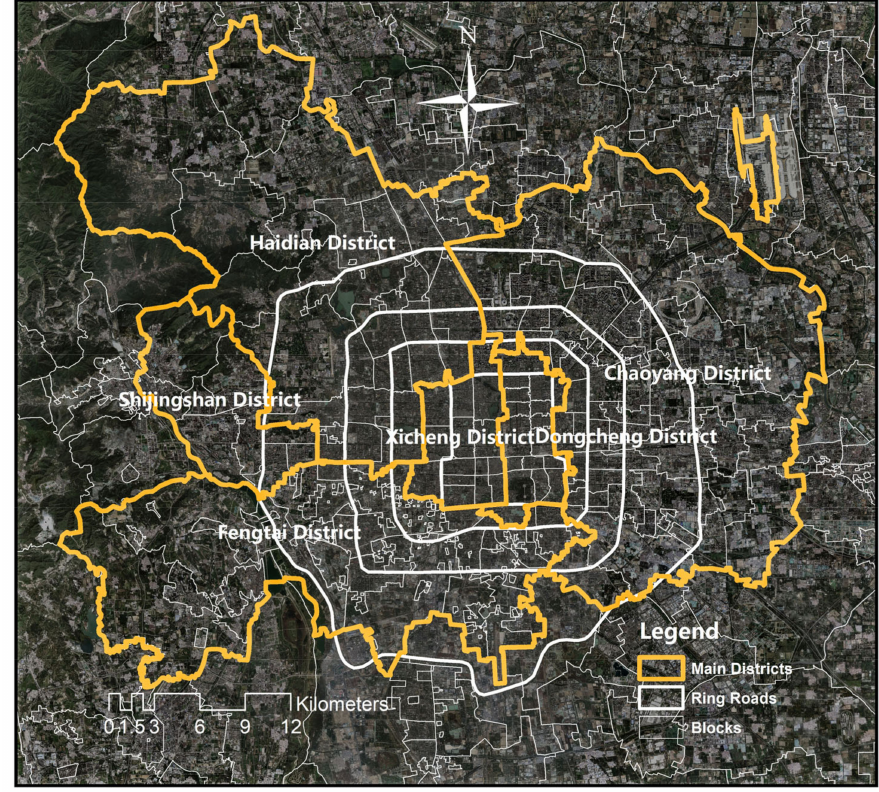
Figure 2. Overview of the research